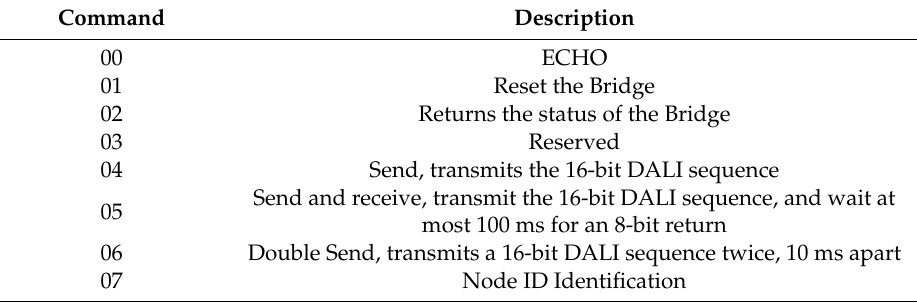
Table 1. General commands of the DALI Bridge and those of the